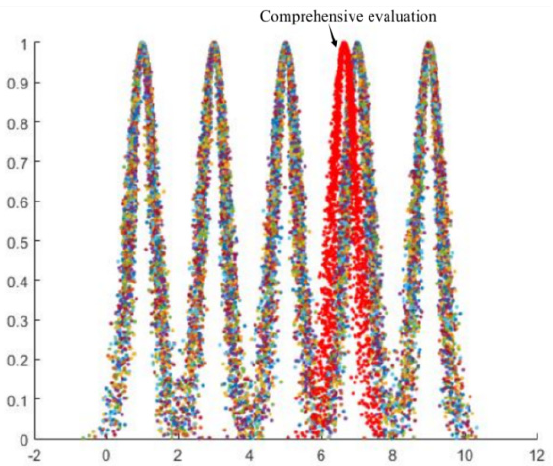
Figure 7. The final evaluation cloud map of the comprehensive multi-index evaluation.